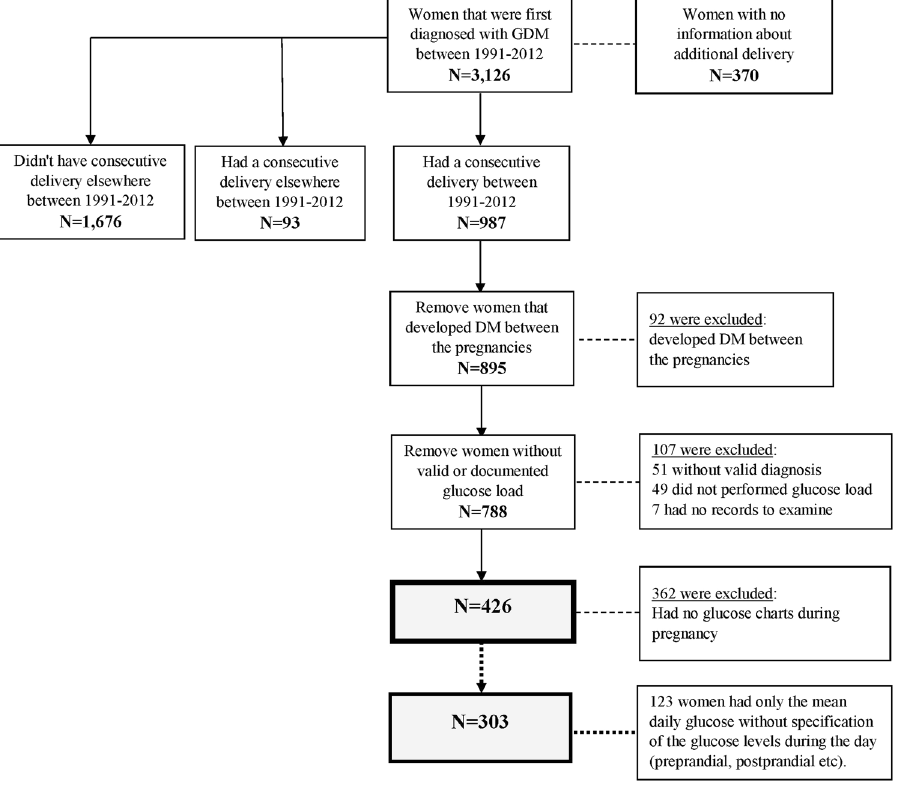
Figure 1. The study flow